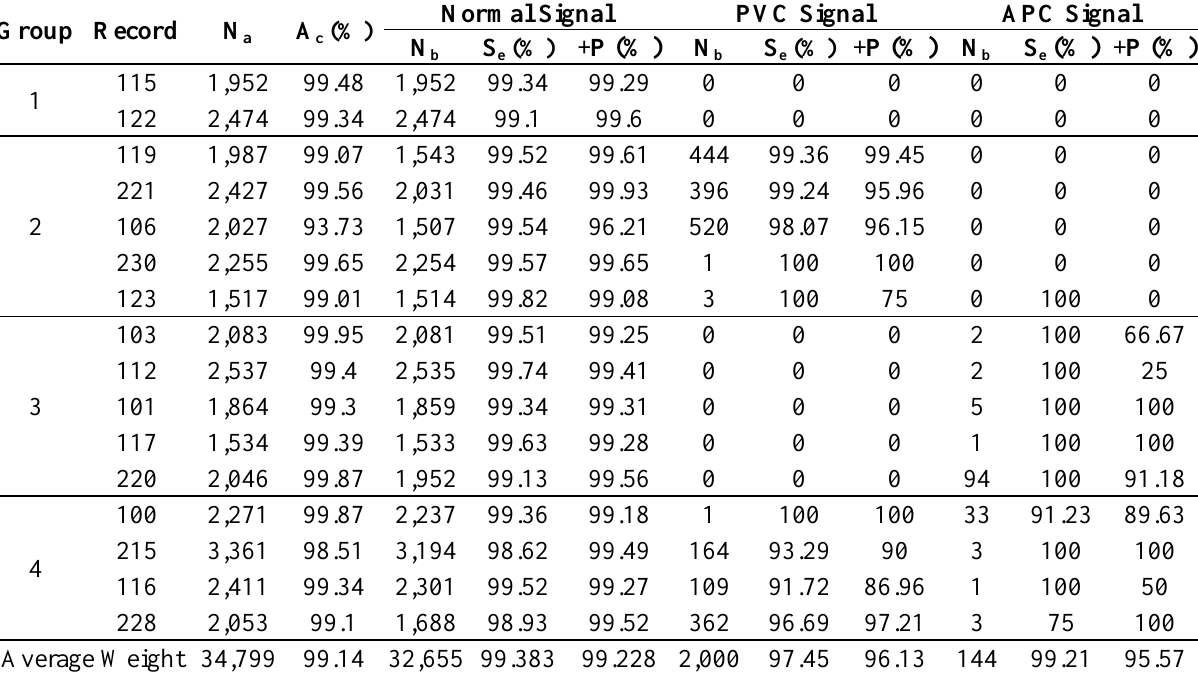
Table 5. ECG abnormal signal detection accuracy based on